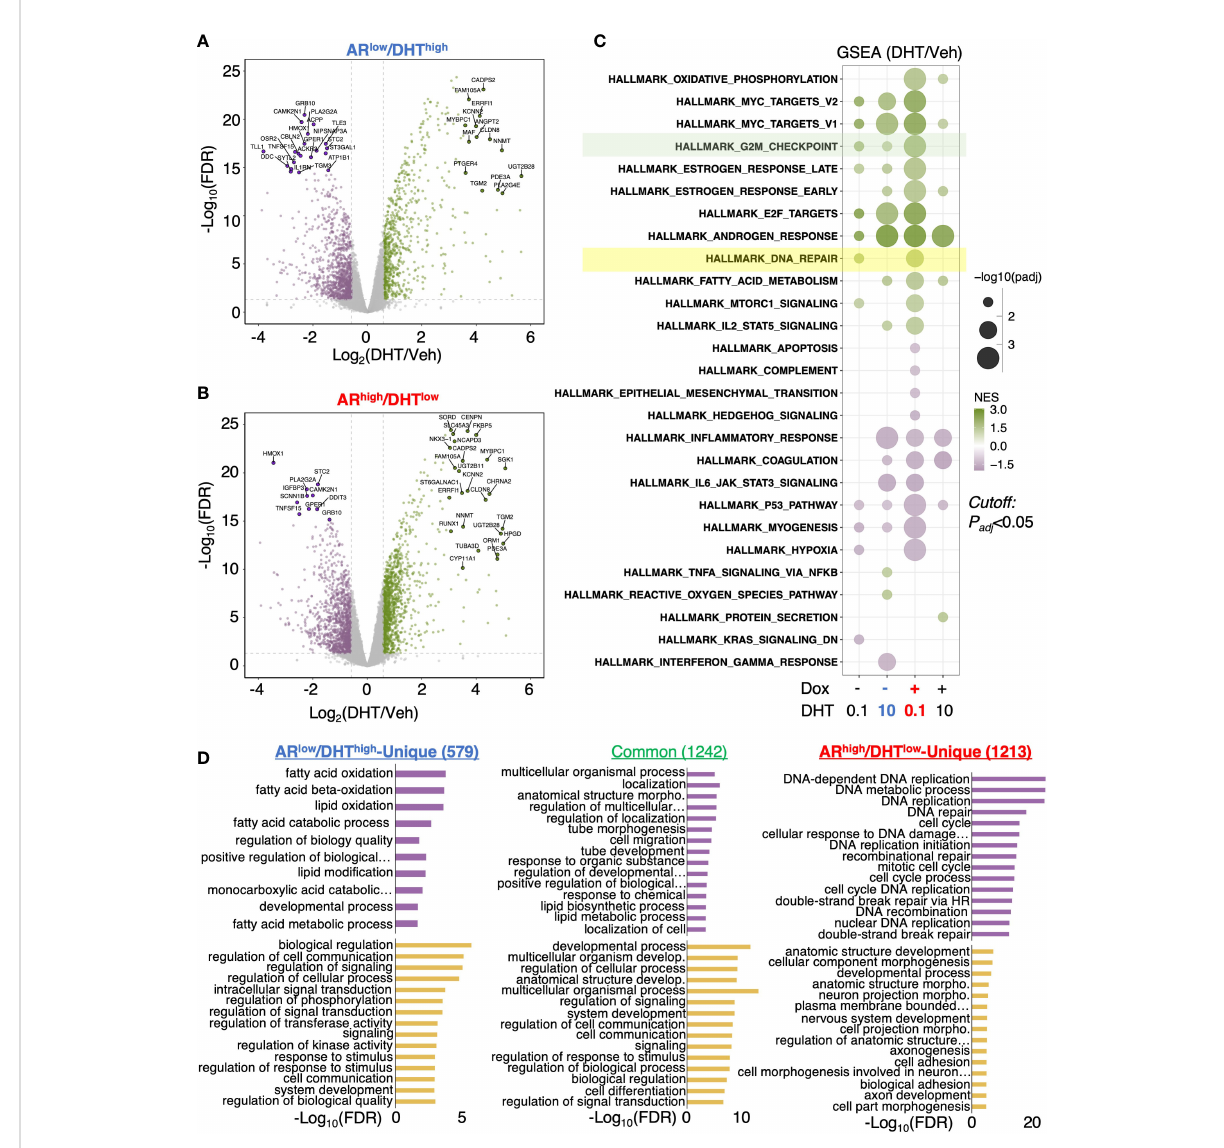
FIGURE 2 AR activates a unique transcription program in AR high /DHT low cells. (A, B) RNA-seq analyses were performed in LNCaP-tet-AR cells pretreated with or without doxycycline and then stimulated with 0, 0.1, or 10 nM DHT (for 24h). Volcano blots for DHT-regulated genes in cells treated with 10 nM DHT alone (A) or with 0.1 nM DHT plus doxycycline (B) were shown. (C) Gene Set Enrichment Analysis (GSEA) for enriched hallmark gene sets. (D) Gene Ontology analysis with the biological process (GO-BP) for differentially expressed genes (fold-change > 1.5; adjusted P - value <